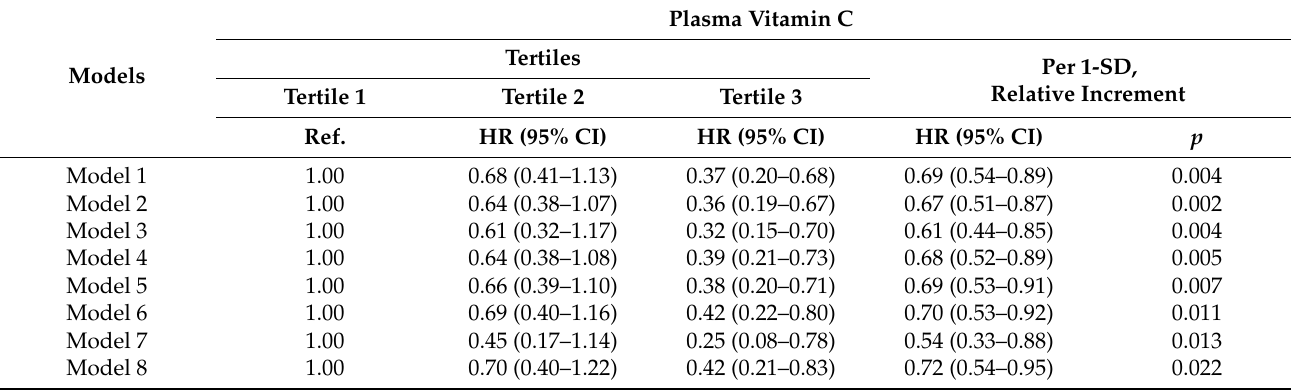
Table 2. Prospective association of plasma vitamin C with risk of graft